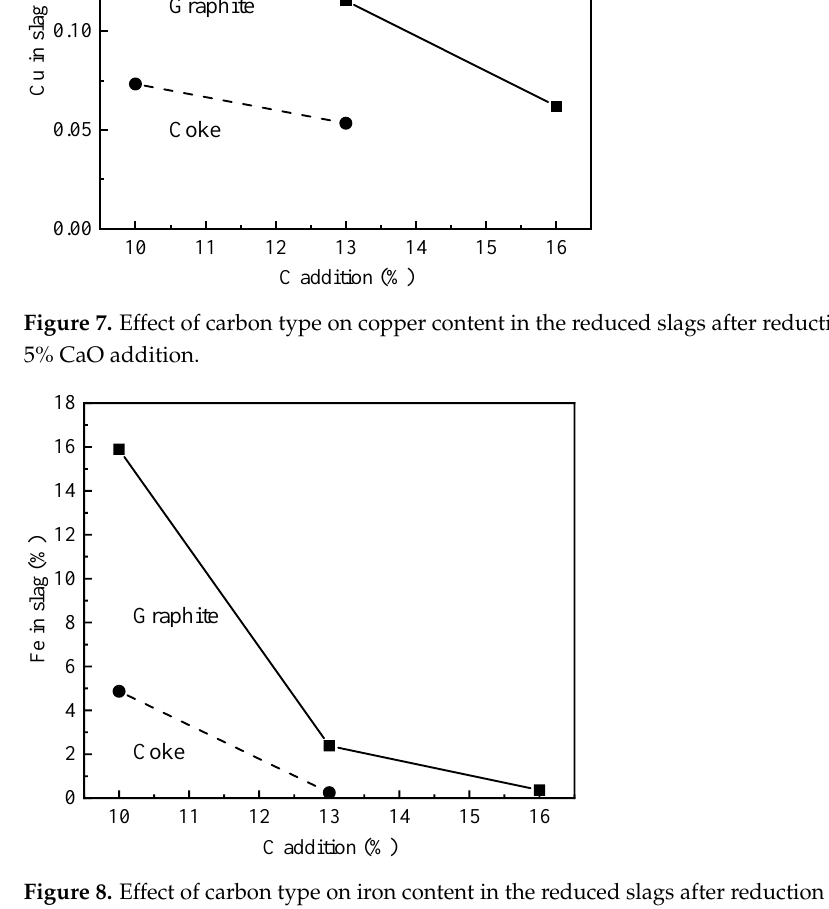
Figure 9. Effect of temperature on the copper and iron contents in the reduced slag, predicted by FactSage 8.2: 13% carbon and 5% CaO. Figure 10 shows the experimental results about the effect of temperature on the cop- per and iron contents in the reduced slag with 5% CaO and 13% graphite. It can be seen that the iron content of the slag decreases slowly at lower temperatures and fast at higher temperatures, which shows the same trend as that predicted by FactSage. In the tempera- ture range investigated (1350 – 1450 °C), copper in the slag continuously increases, which